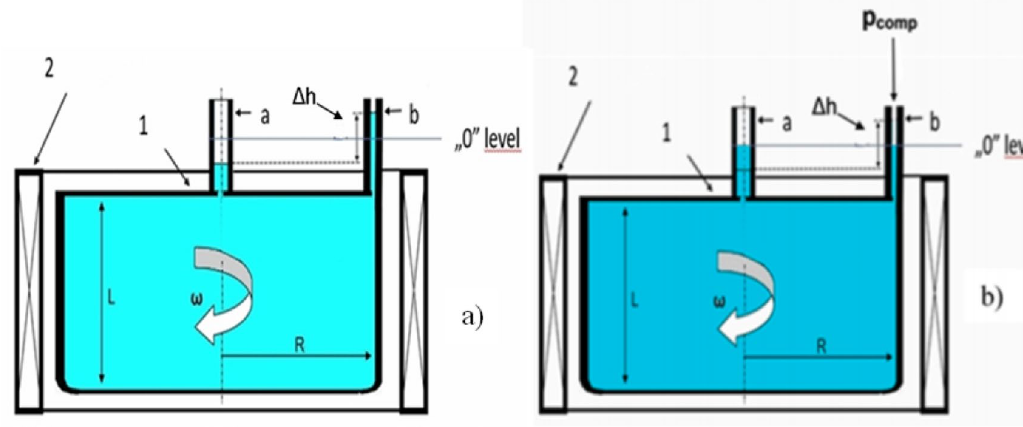
Figure 3. ( a ) The melt level in the gauges when the magnetic induction was occurring (1) closed tank, (2) rotating magnetic field (RMF) inductor, and ‘a’ and ‘b’ gauges. ( b ) The melt level in the gauges at the pressure